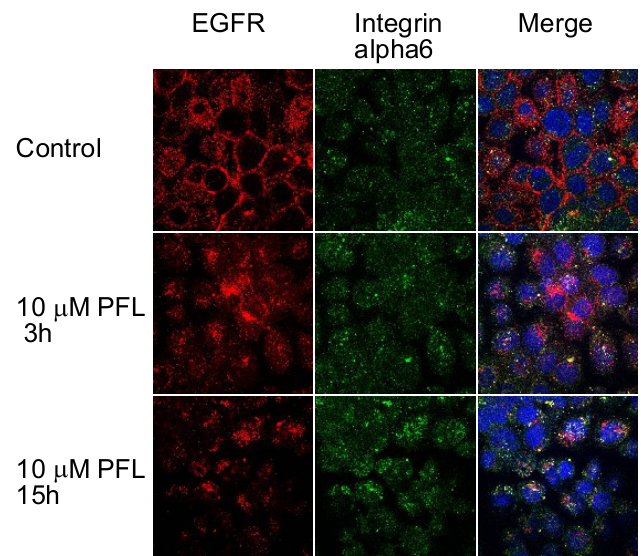
Figure 2. Cellular distribution of integrin α6 and EGFR with PFL treatment. MKN28 cells were incubated with 10 μM PFL for the indicated time. Integrin α6 and EGFR were visualized by confocal fluorescence microscopy. Representative images depict the cellular localization of integrin α6 (green) and EGFR (red). Co-localization of both proteins is represented as a yellow signal (merged panel). The figure shows results of one experiment that was replicated at least twice with similar